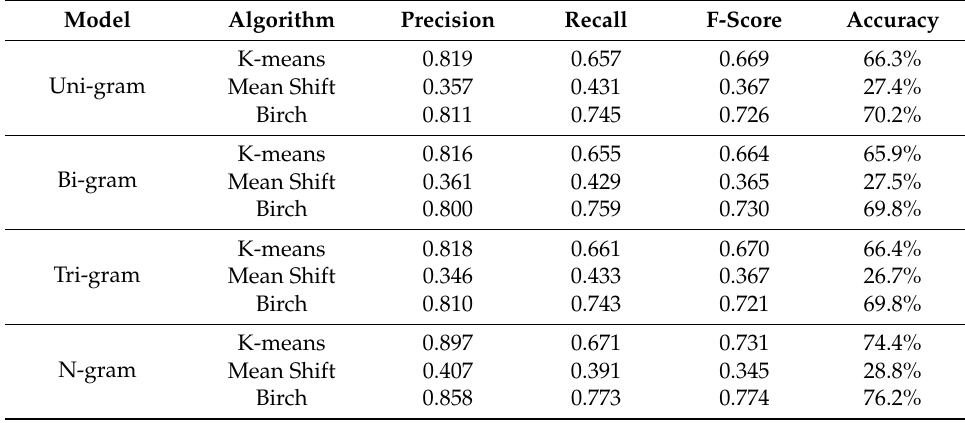
Table 2. Results of clustering algorithms with n-gram models on the training dataset.